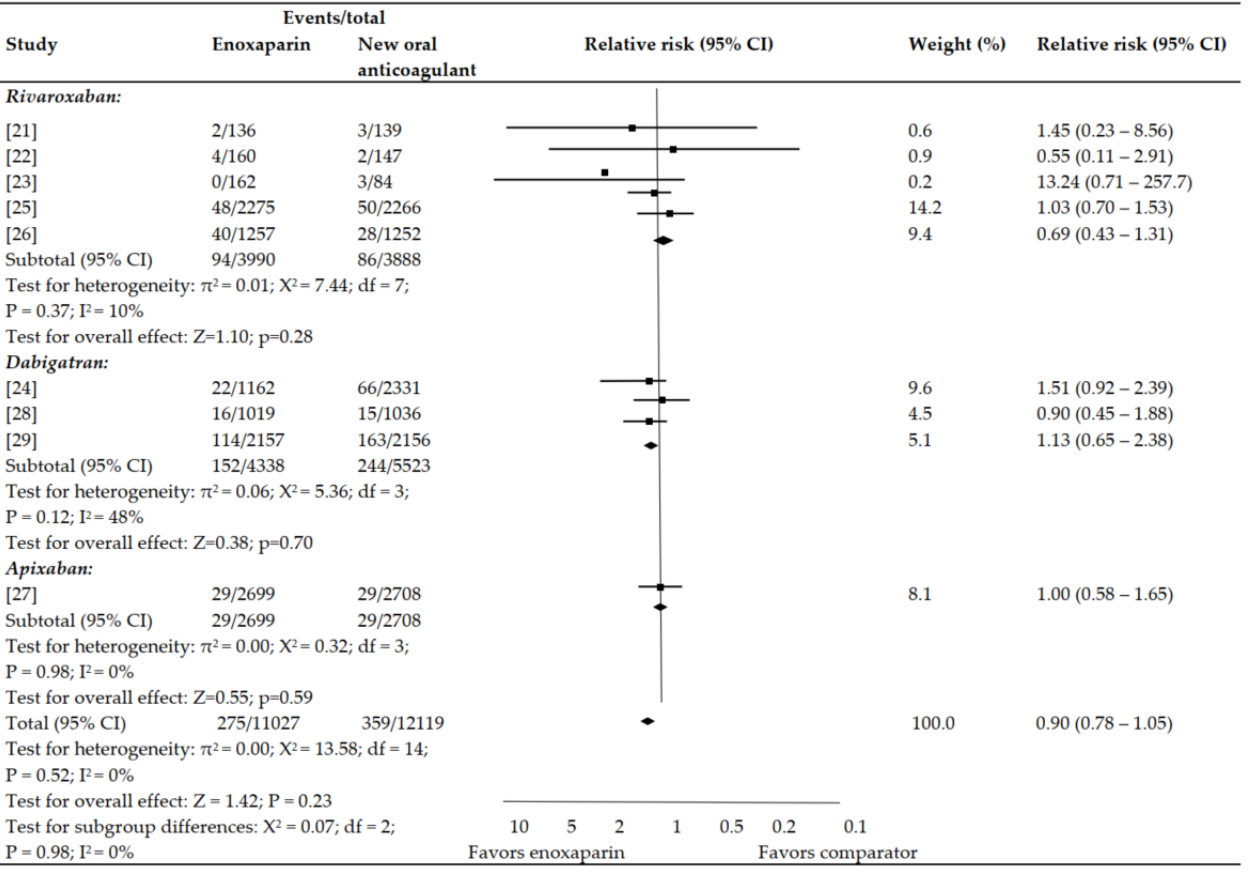
Figure 4. Net clinical